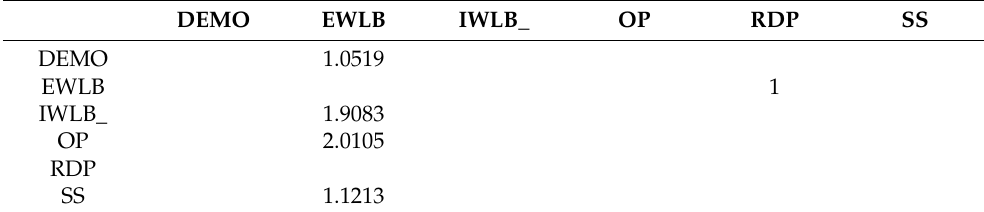
Table 2. Full Collinearity